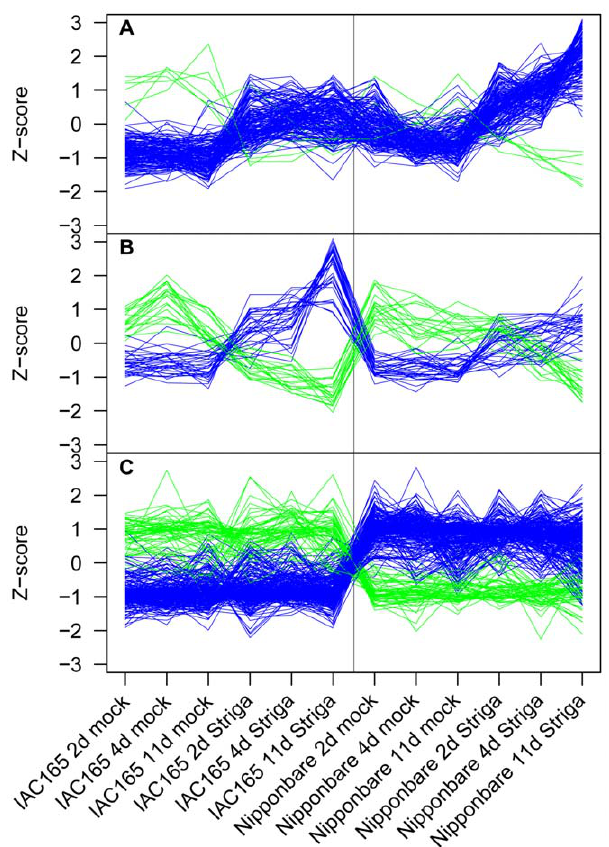
Figure 2. Normalized expression values of modules of genes identified from a Striga root infection study. Gene expression values from Striga hermonthica root infection time course of rice cultivars IAC165 and Nipponbare were processed using Weighted Gene Coexpression Network Analysis to identify modules of highly correlated genes [36,43]. Expression data are represented here as normalized values (Z-scores). Two gene modules, (A) GSE10373-blue and (B) GSE10373-brown, display differential responses between genes in the two cultivars in response to infection by S. hermonthica . Genes from one module, (C) GSE10373-turquoise, are differentially expressed between the two rice cultivars but are not responsive to infection by S. hermonthica . Plots for genes that are positively correlated with each other within a module are shown in the same color. Genes within a module that are displayed in different colors are anti-correlated.